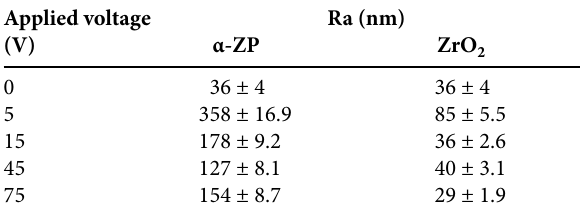
Table 2 Average roughness values for Zr